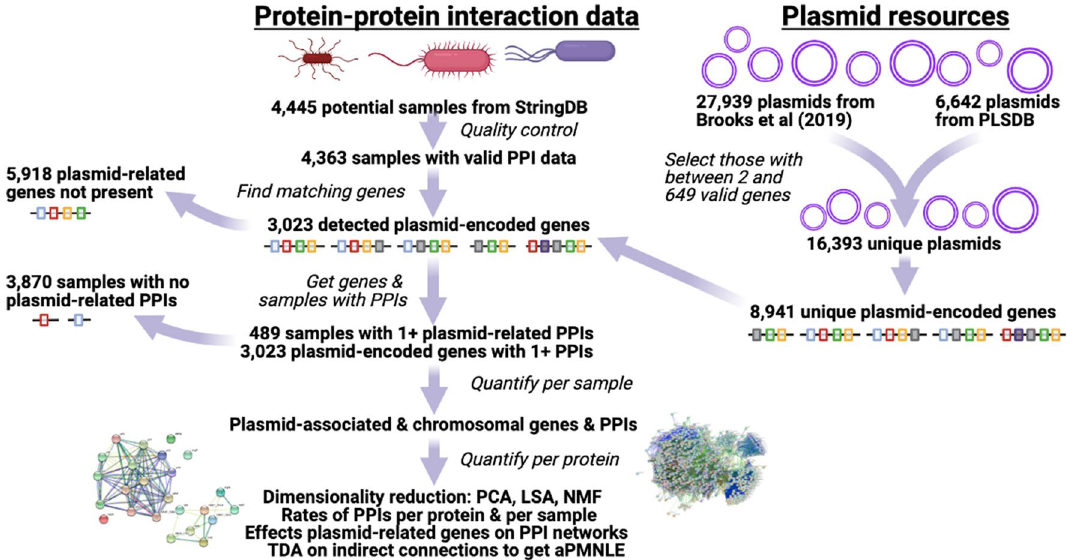
Figure 1. Summary of data sources and analytical steps. The plasmid resources (top right) and protein–protein interaction (PPI) data from StringDB were ultimately merged based on gene matches. Plasmid-encoded proteins with PPIs were the focus, and gene prevalence and PPI level per sample were computed, as well as more general patterns across sample based on a range of complementary methods. Created with